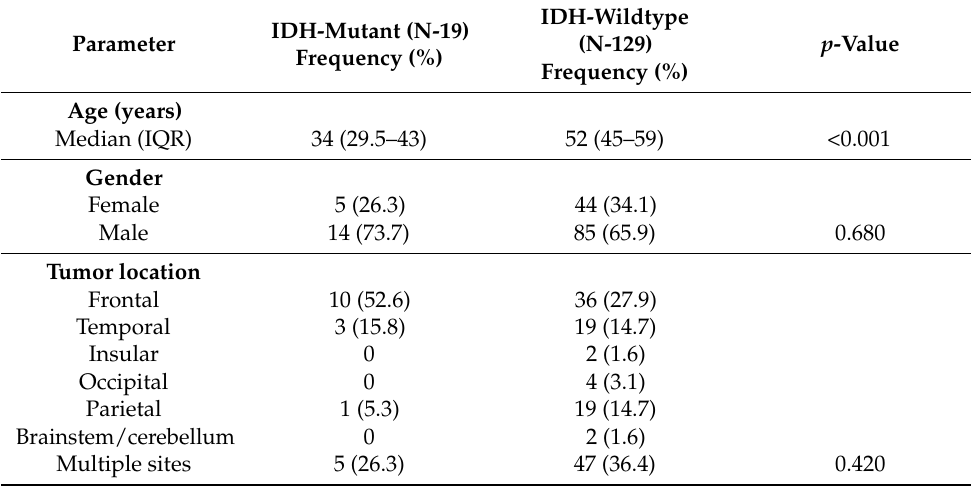
Figure 2. ( a − h ) FLAIR, T2, T1, post-contrast T1, GRE, DTI, perfusion color map, and graph repre- senting an IDH-wildtype glioblastoma. Images a − e reveal a heterogeneous peripheral rim-enhanc- ing right frontoparietal mass with significant internal necrosis and hemorrhage. Image f is a DTI